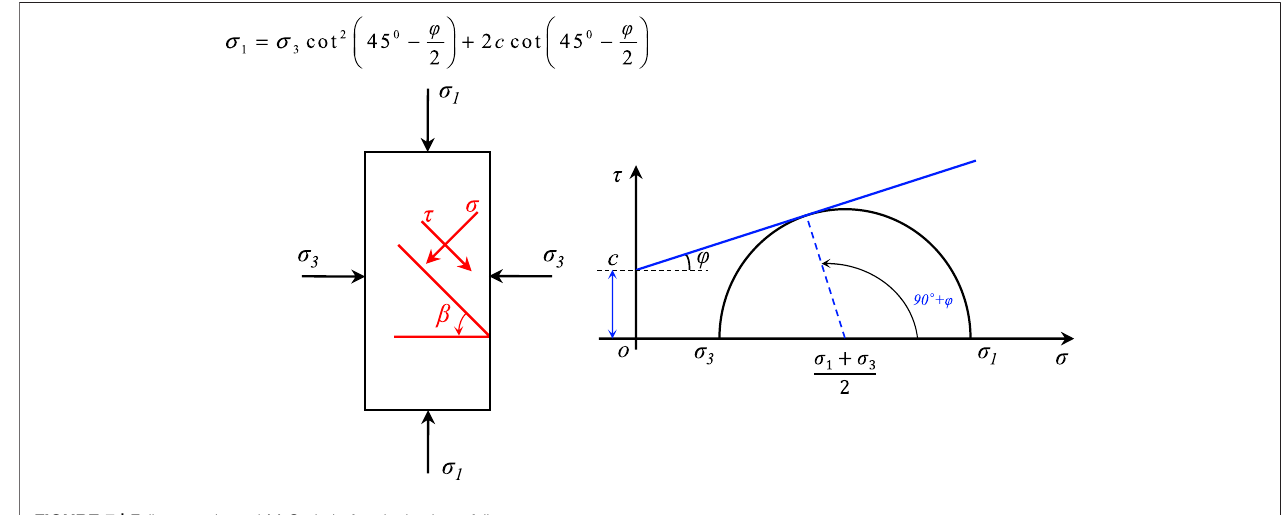
FIGURE 7 | Failure mode and M-C circle for single shear failure.